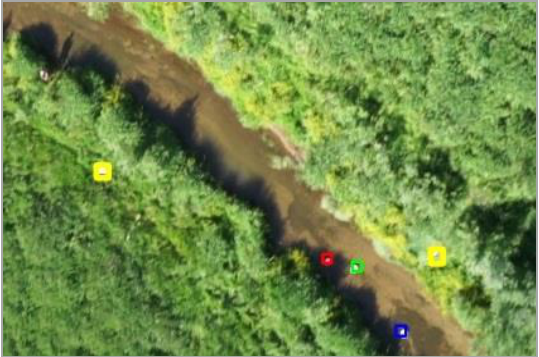
Figure 4a. Floats detected in RGB imagery